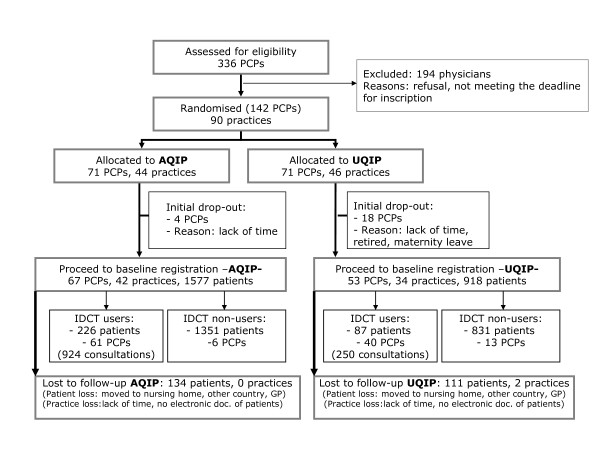
Flowchart displaying Enrollment of patients and physicians in the study.